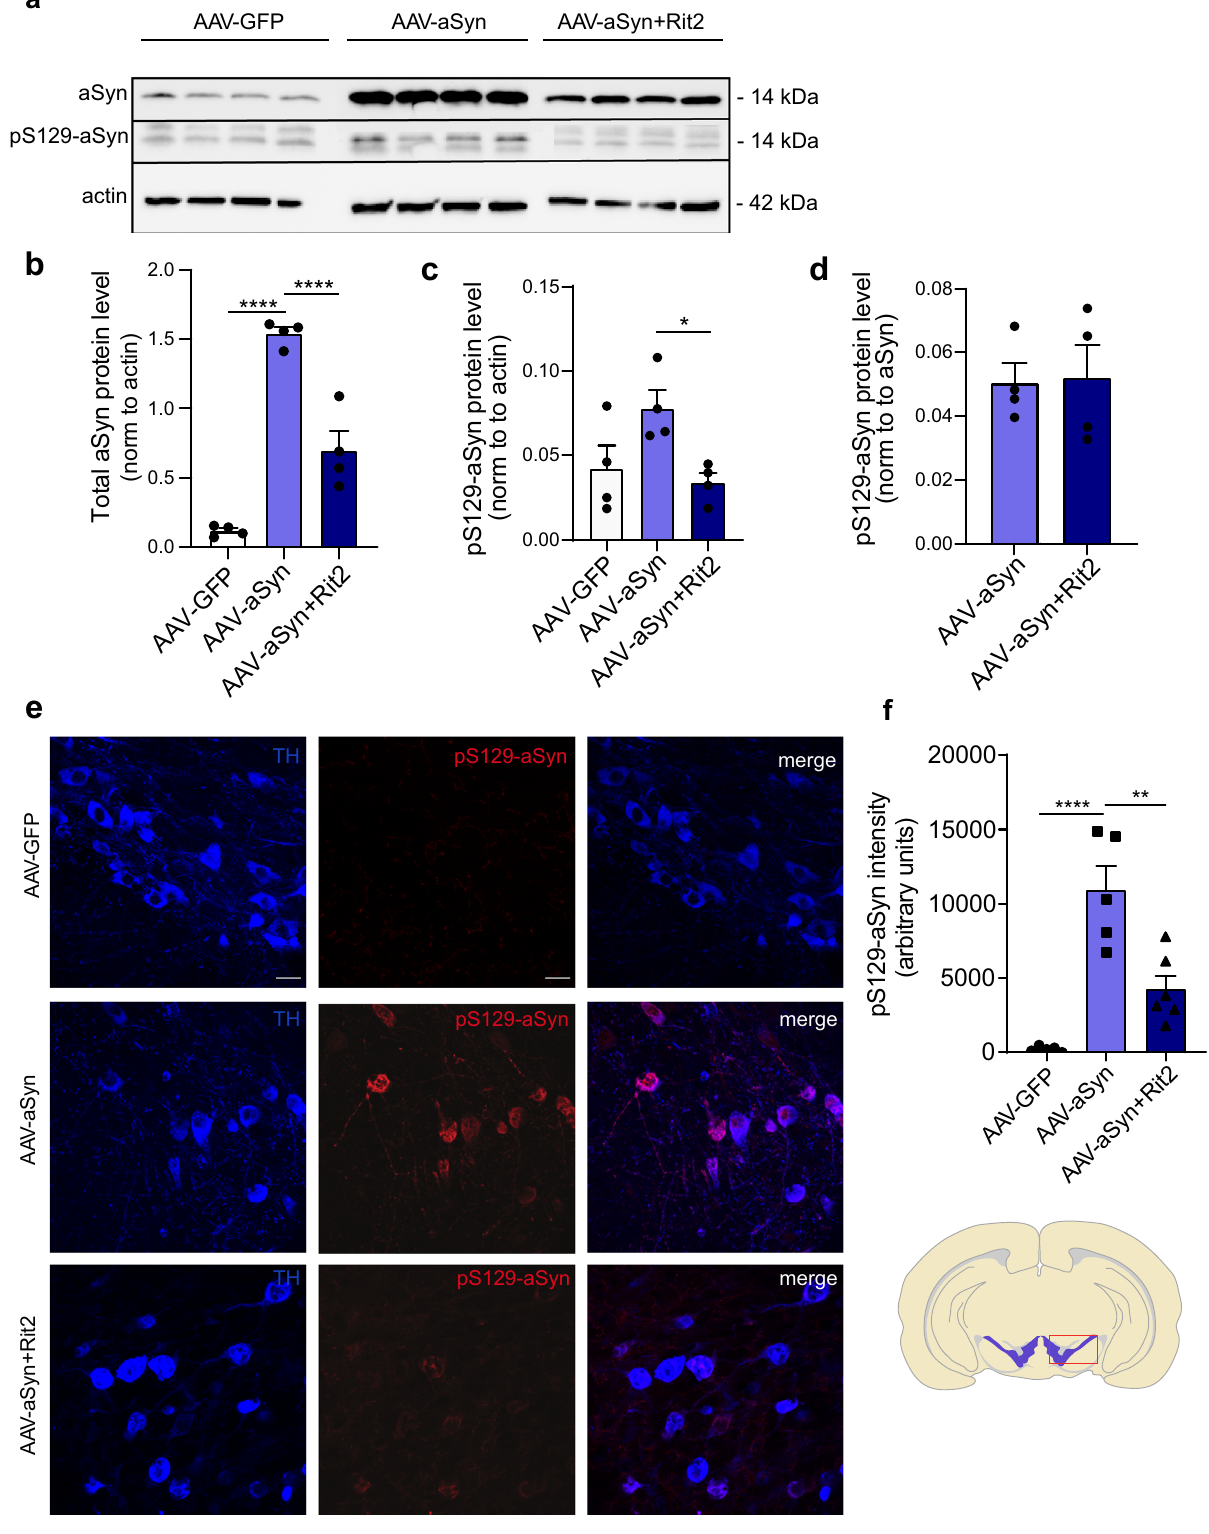
autophagosomes/autolysosomes (Supplementary Fig. 9g, h).